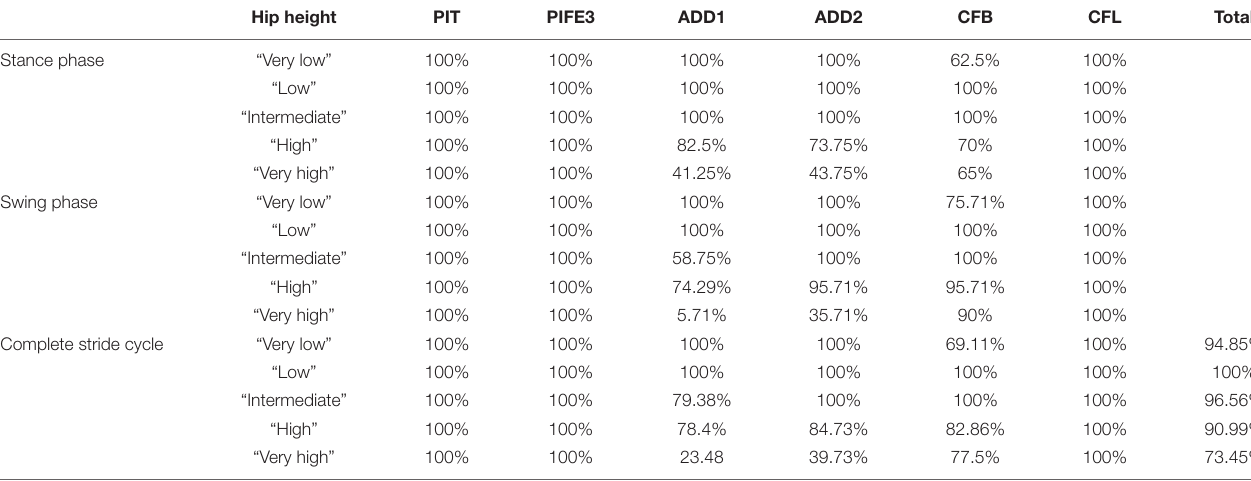
TABLE 1 | Percentage of the stride cycle that each modeled muscle maintained optimal muscle strain (i.e., within 70 and 130% of reference length) in Caiman. Hip height PIT PIFE3